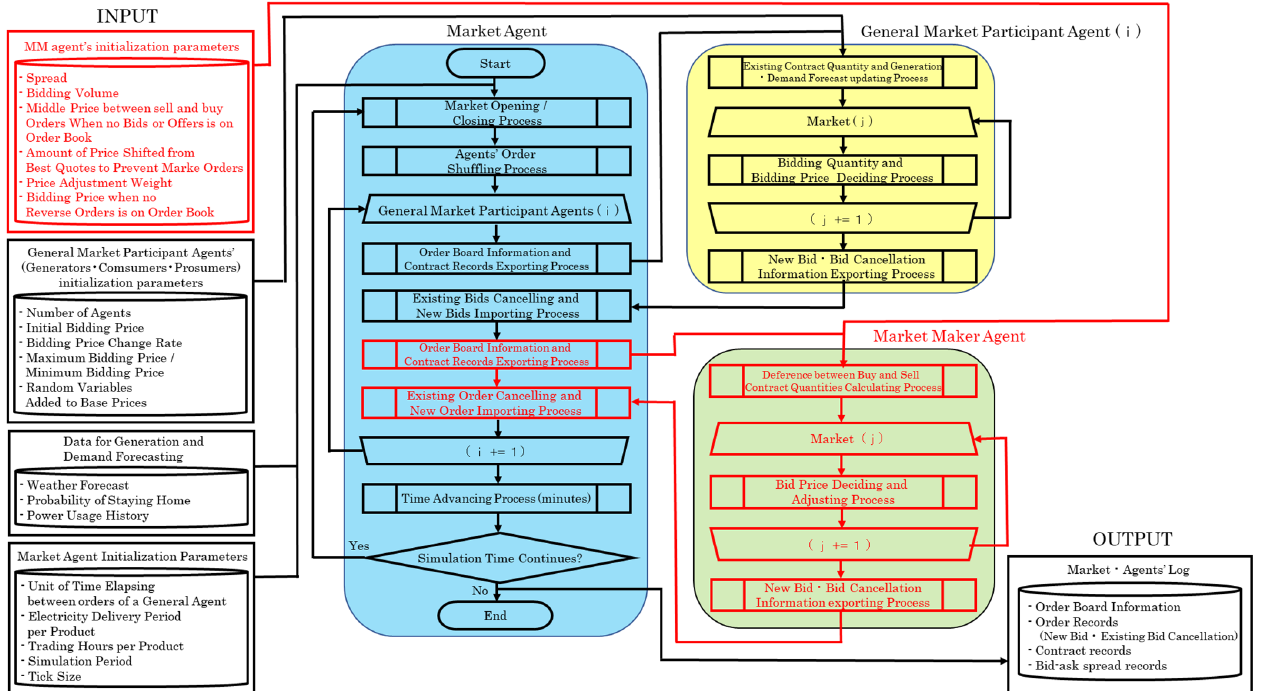
Figure 8. Information flow in the simulation system.